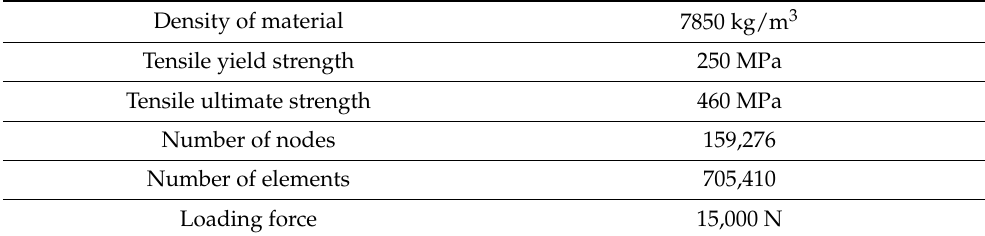
Table 4. Input and output values of the analysis.